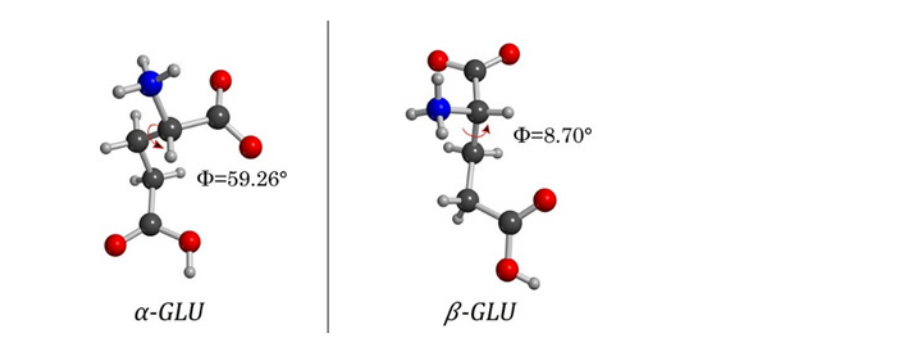
Figure 14. Terahertz spectrum of N-acetylaspartate (NAA) (courtesy of Y. Peng). Myo-Inositol has also been found to be increased in gliomatosis and other cerebral diseases associated with marked astrogliosis [165]. Apart from the concentration of Myo-Inositol, the ratio between Myo-Inositol and creatine can also be used to predict the grade of cerebral gliomas. Myo-Inositol/creatine was higher (2.14 ± 1.4) in patients with low-grade astrocytoma and lower in patients with anaplastic astrocytoma (0.39 ± 0.11) and glioblastoma (0.025 ± 0.06) [166]. These two substances have also been tested by THz spectroscopy. Yang et al. [167] tested the THz spectrum of Myo-Inositol and found four